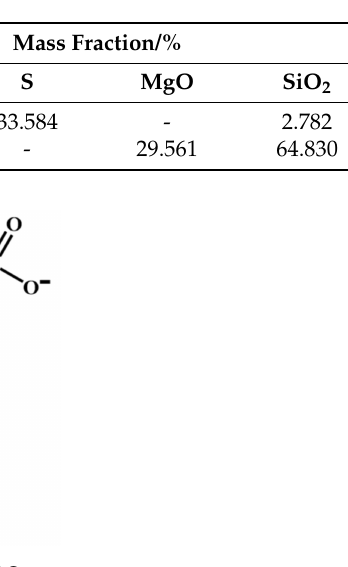
Figure 2. Monomeric molecular structure of